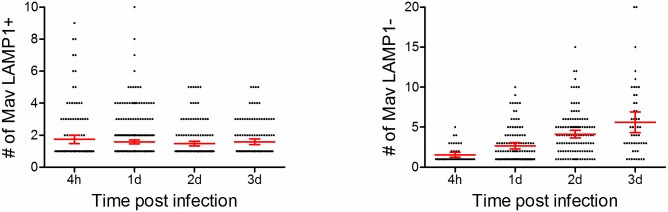
MavCs, but not MavPLs, support Mav replication.Human MDMs were infected with Mav-CFP for 10 min, chased for 5 min to 3d, fixed with 4% PFA and analyzed by confocal microscopy. In situ quantification of the actual number of Mav inside (left panel) or outside (right panel) LAMP1+ compartments at different time points, including the mean value +/- 95% confidence intervals.